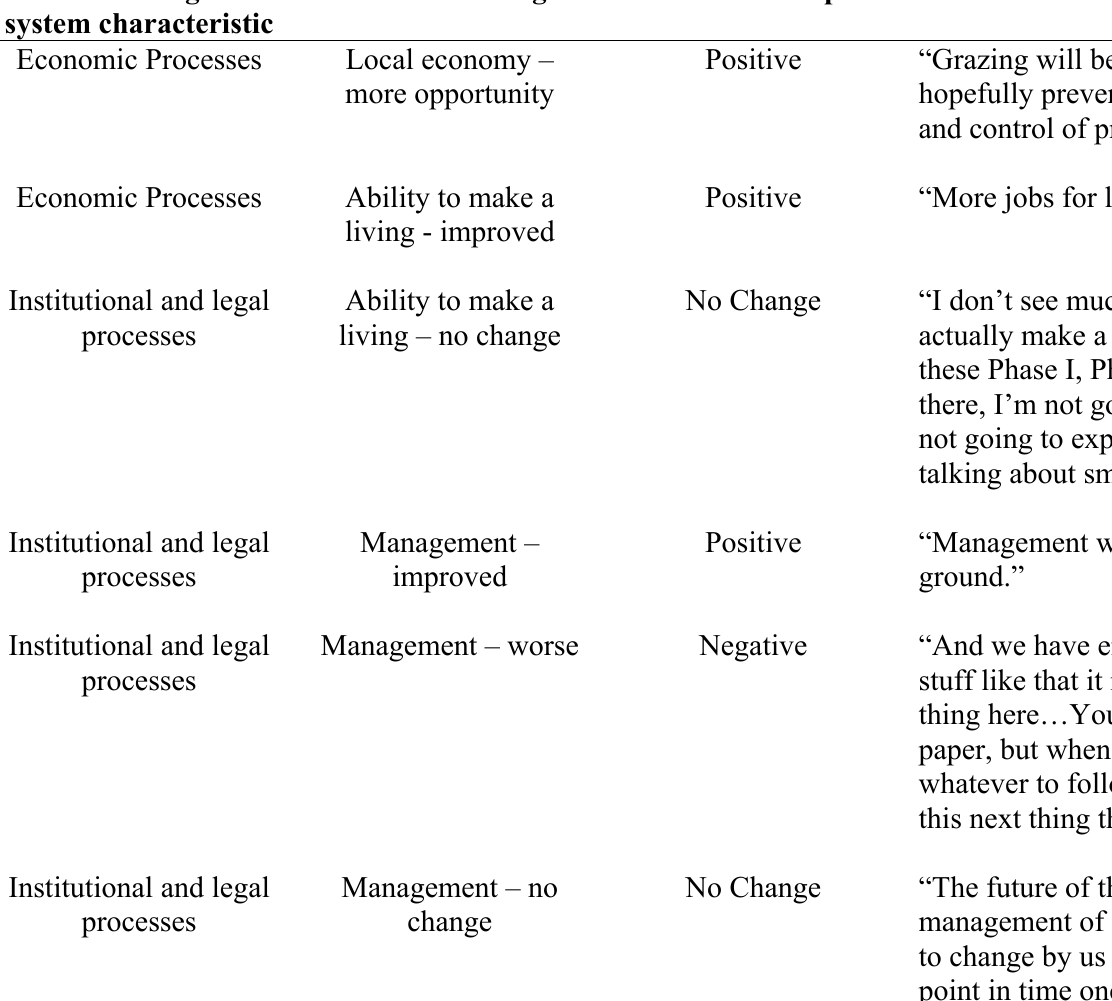
Table 2. Workshop participants' responses to the full suite